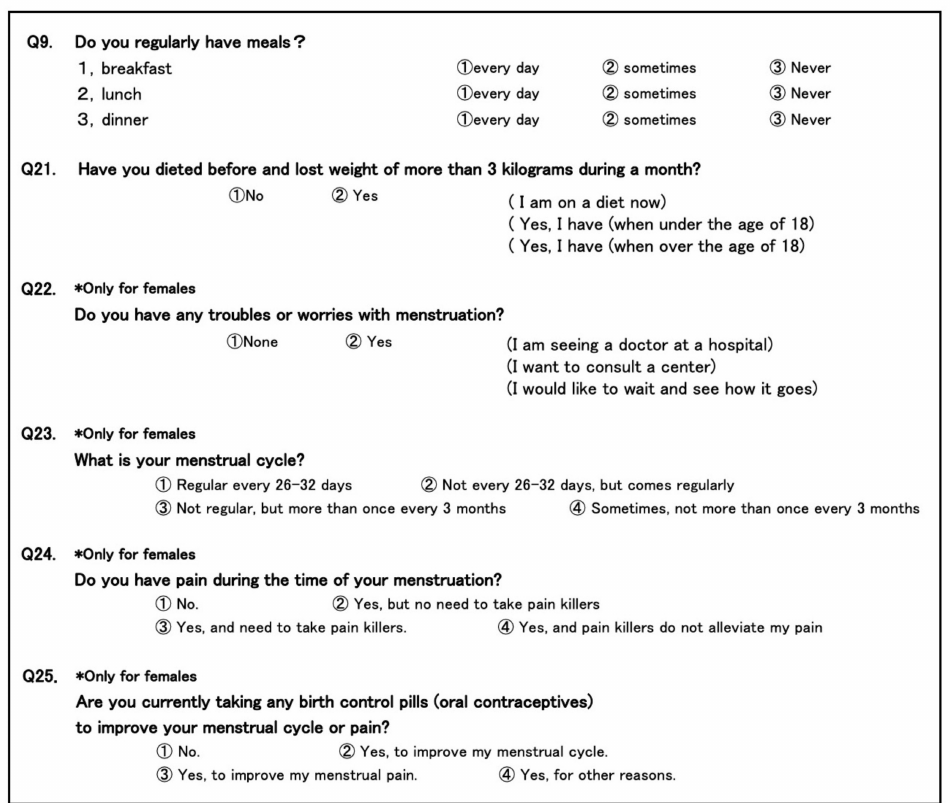
Figure 1. The contents of a survey sheet. Food-frequency information about breakfast, lunch, and dinner is obtained by question no. 9. History of dieting is strictly defined as those who experienced more than 3 kg reduction of body weight during a month, and this item was added to the survey sheet (question no. 21). For menstrual disorders, four questionnaire entries: troubles or worries with menstruation, menstrual irregularity, menstrual pain, and use of oral contraceptives, are prepared in question nos.